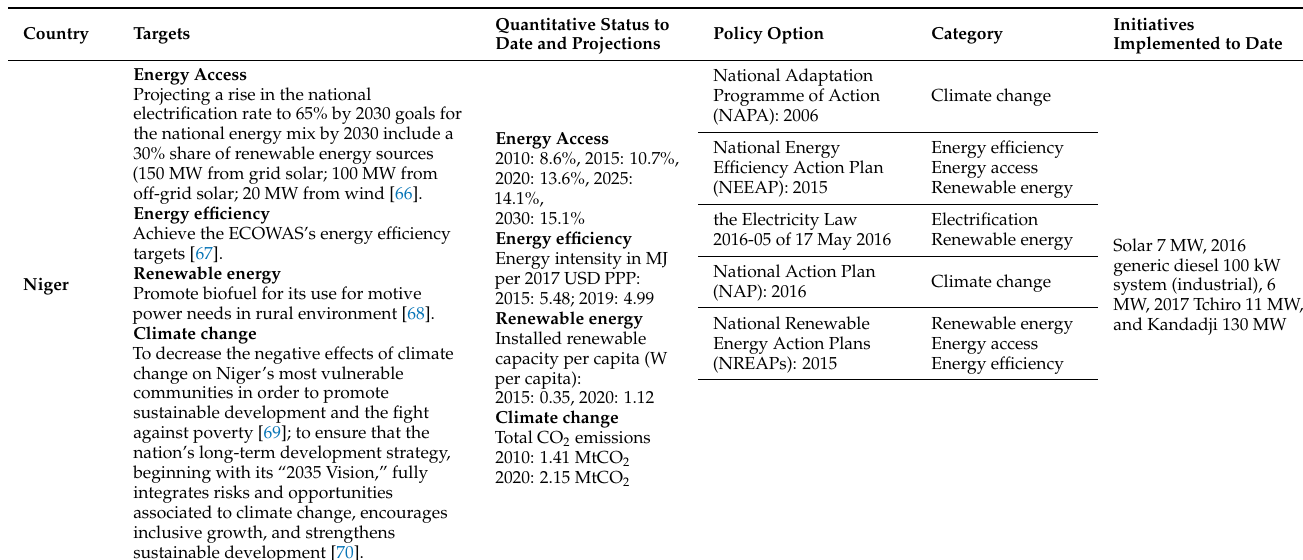
Table 11. Niger (data from [22–24]).